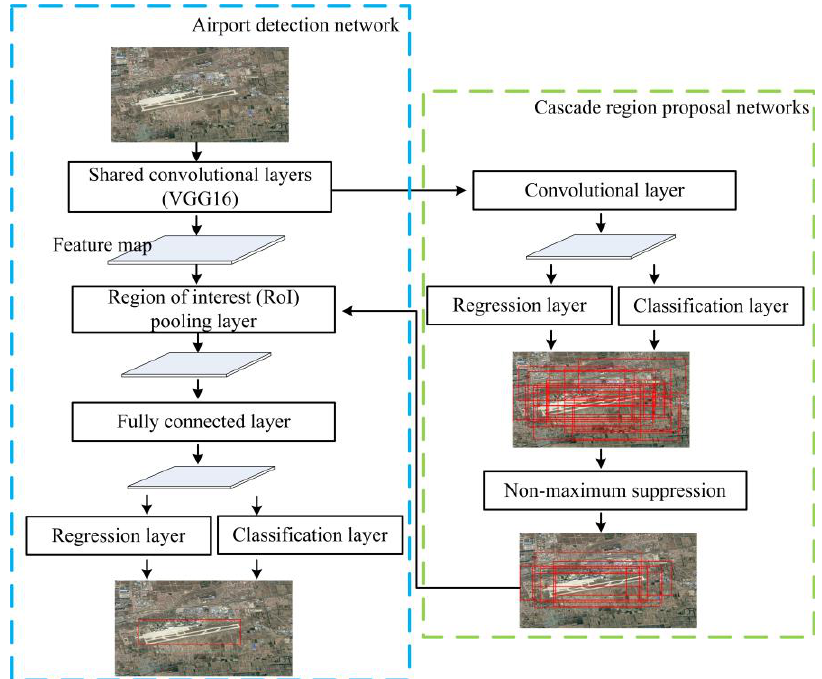
Figure 1. The airport detection network architecture is shown in the blue frame, and the cascade region proposal network architecture is shown in the green frame.